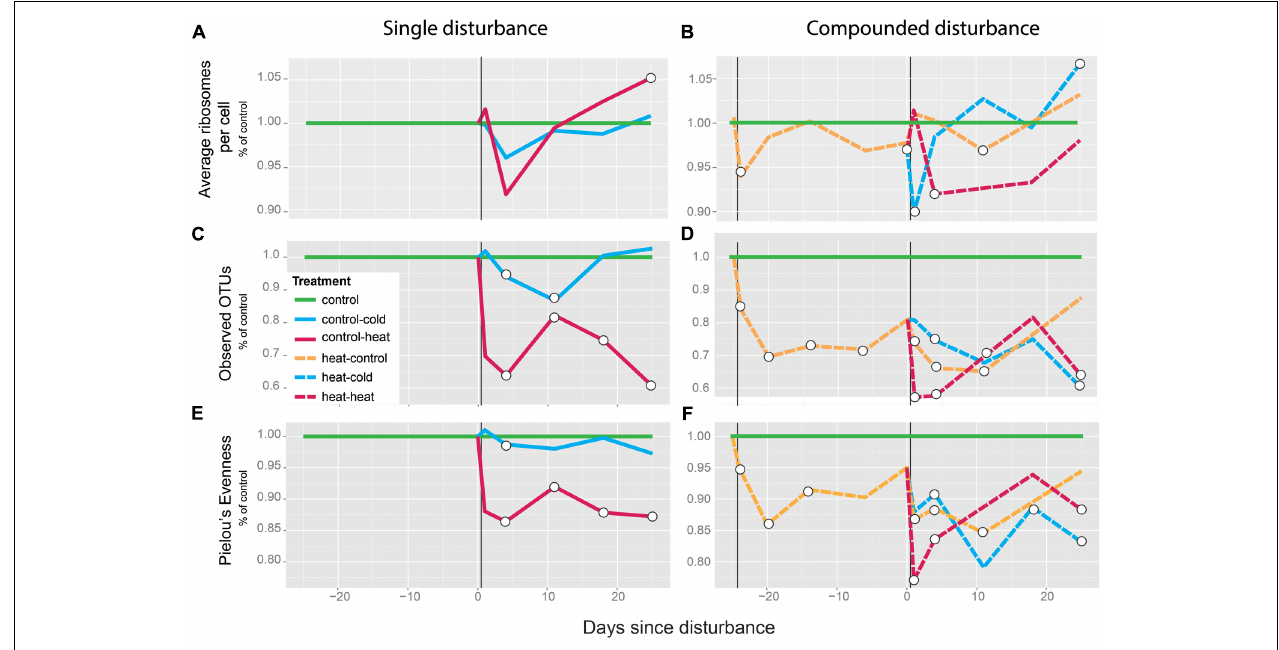
FIGURE 2 | Effects of disturbance legacy of heat shock on the active community. Average ribosomes per cell (A,B) , richness (C,D) , and evenness (E,F) are shown as normalized ratios relative to the mean undisturbed control values for each respective time point. Average ribosomes per cell are measured as total 16S rRNA gene copies normalized by the number of 16S rRNA gene transcripts. Statistically significant differences between the undisturbed-control and each treatment along time are shown as hollow circles (two-tailed t -test, p < 0.05). Vertical black lines indicate the disturbance event. Normalizations of treatments with prior heat shocks relative to the heat–control treatment are available in Supplementary Figure S5. A list of the samples lost during extraction and processing is included in Supplementary Table S6.